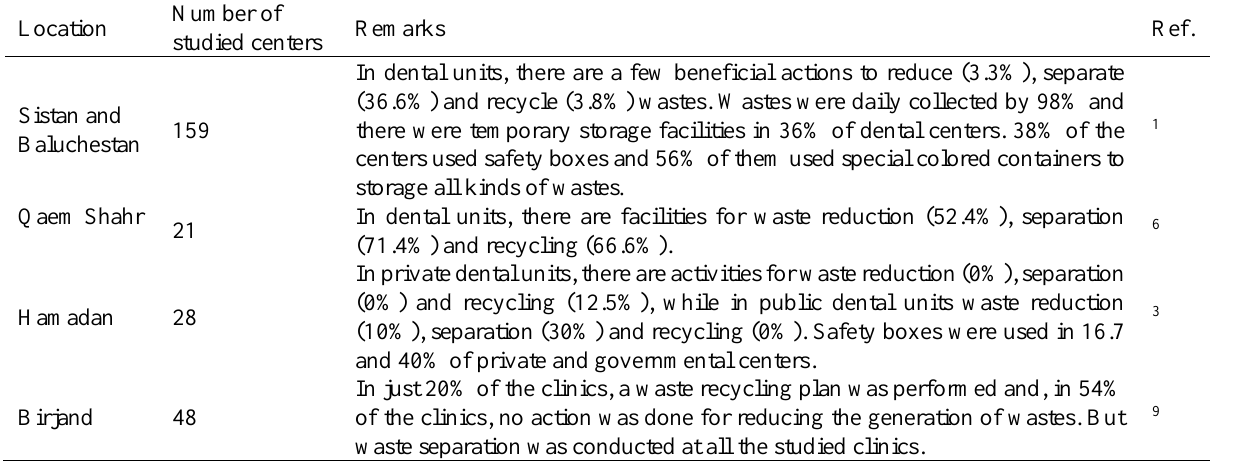
Table 3. Status of dental waste management in some cities in Iran